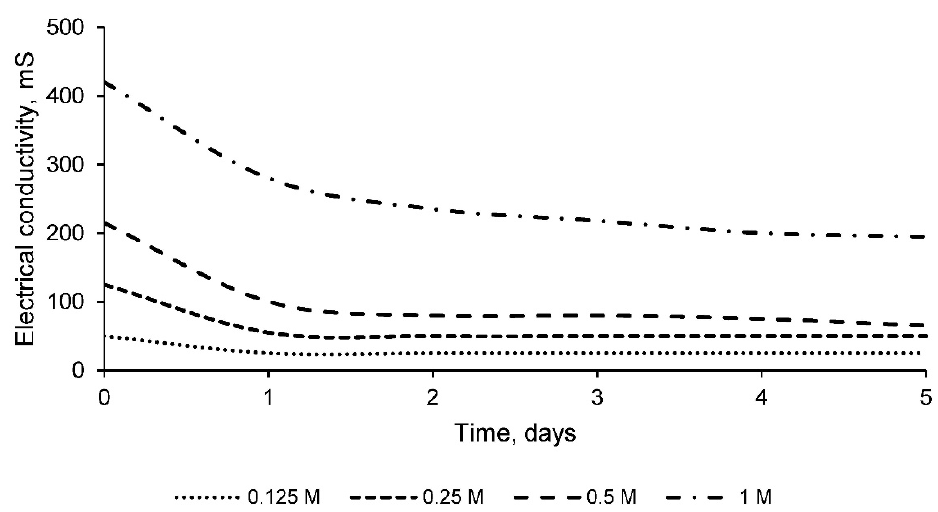
Figure 2. Electrical conductivity of 0.125, 0.25, 1, and 2 molar solutions of sulfuric acid at different times during leaching process with electric furnace dusts.